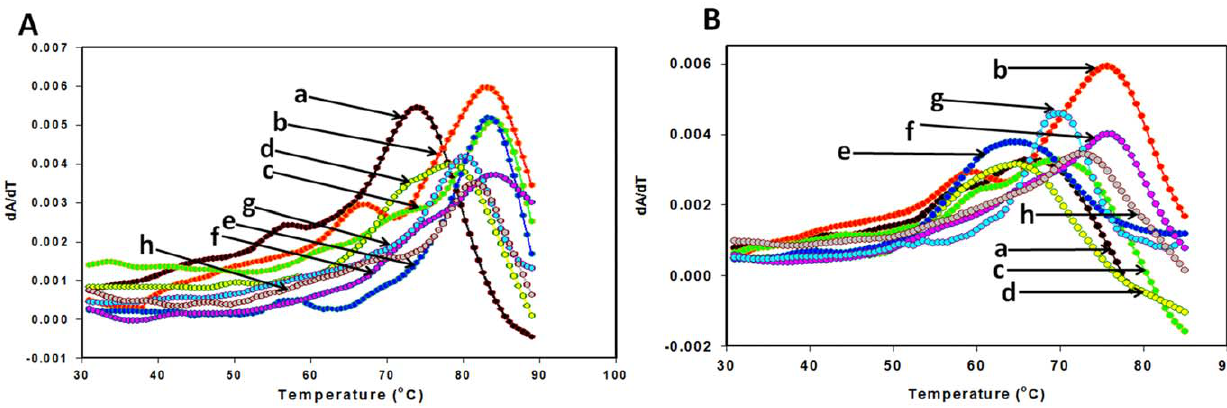
Figure 3. UV T m curves. UV T m curves (A)PNA :RNA antiparallel duplexes of (a)PNA 72, (b)PNA 98, (c) PNA 102,(d) PNA 110, (e) PNA 237,(f) PNA 251,(g) PNA 271, (h) PNA 332, (B) PNA :DNA antiparallel duplexes of (a) PNA 72,(b) PNA 98,(c) PNA 102,(d) PNA 110, (e) PNA 237,(f) PNA 251,(g) PNA 271,(h) PNA 332. 10 mM sodium phosphate buffer, pH 7 containing NaCl (100 mM) and EDTA (0.1 mM) buffer was used for UV T m melting studies.